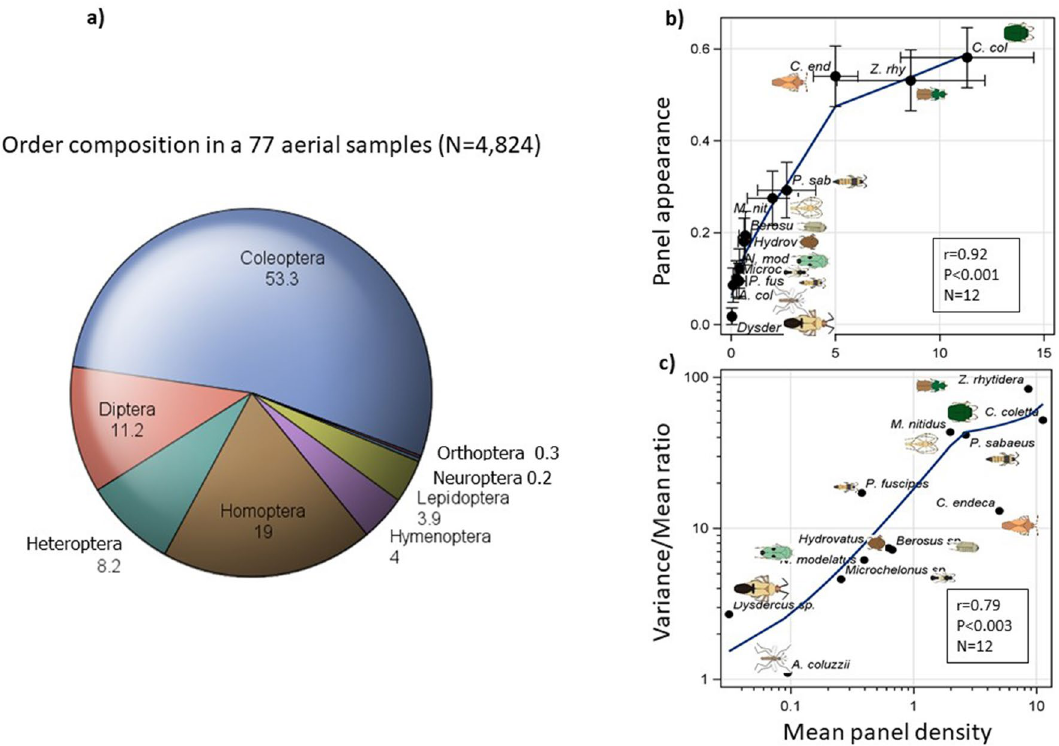
Figure 2. ( a ) Overall diversity (by insect orders) of aerial collection estimated based on samples from 70 sticky nets. Orders represented by less than 3 specimens (Blattodea, Thysanoptera, Megaloptera, Psocoptera, and Phasmatodea) are not shown. ( b ) Relationship between overall species density/panel (+ 95% CI) and the fraction of nets on which capture occurred on (+ 95% CI) as a measure of the regularity of high altitude flight activity. Insets show the Pearson correlation coefficient (r), its P value (P) and sample size (N). Schematic insect silhouettes are not to scale. ( c ) The relationship between the variance to mean ratio and its mean panel (Fig. S5b and S5c), possibly because rainstorm conditions inhibit migration 24 or because aerial sampling did not include such nights. Statistical models that evaluated the effects of these weather parameters on high-altitude activity revealed that flights of certain taxa were more common under lower wind speed (seven taxa) and higher RH (four taxa, Table 3).